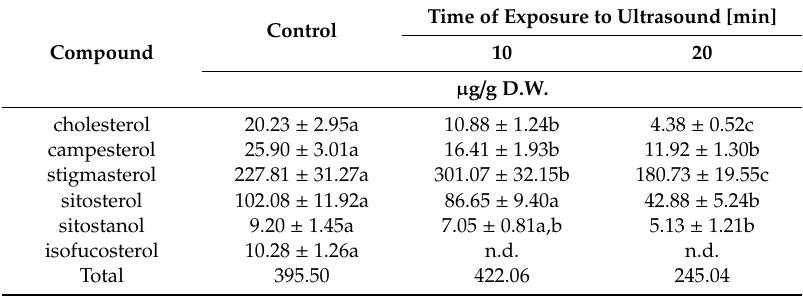
Table 5. The content of sterols in line CC16 hairy root tissue after elicitation with ultrasound.